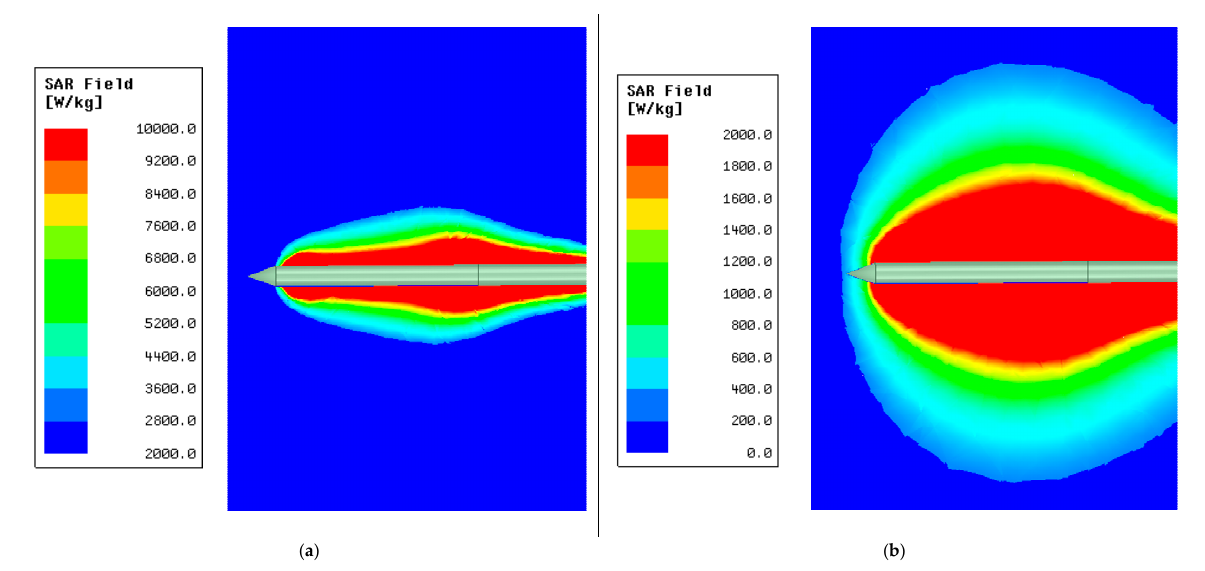
Figure 5. Color contour diagrams of Specific Absorption Rate (SAR) in the liver corresponding to Case 5 for a 30 W input power and a coolant mass flow rate of 1 g/s. Images ( a ) and ( b ) have separate legend ranges to show different SAR values.